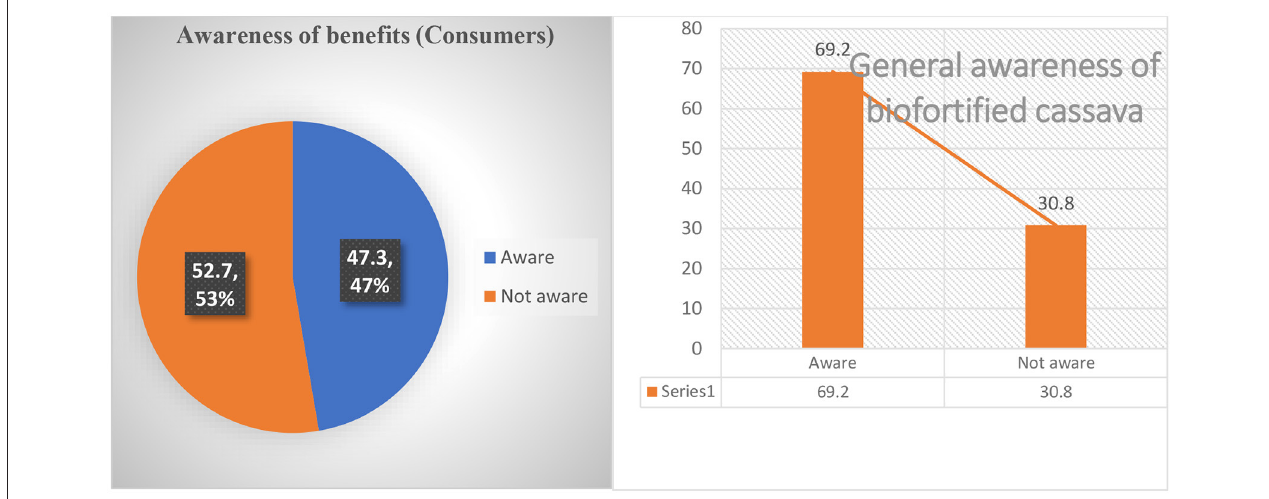
FIGURE 1 | Awareness of biofortified cassava product and benefits for consumers. The left side illustrates total consumer awareness of the benefits of cassava. The right side depicts consumer awareness of biofortified cassava.